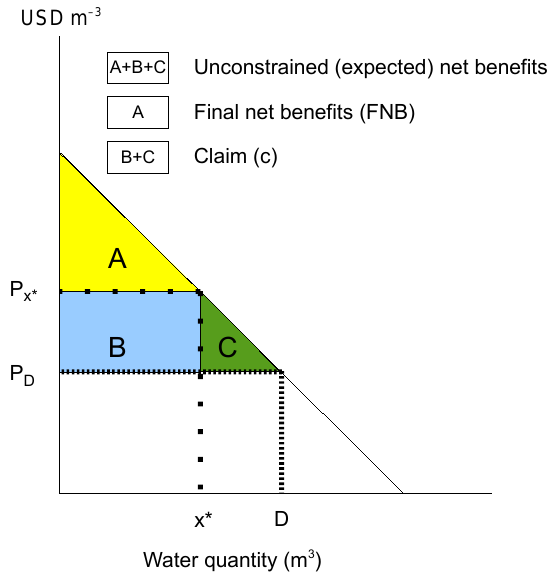
Figure 1. Demand curve. D: quantity of water demanded for a time period; x ∗ : quantity of water allocated for a time period; P: price of water.